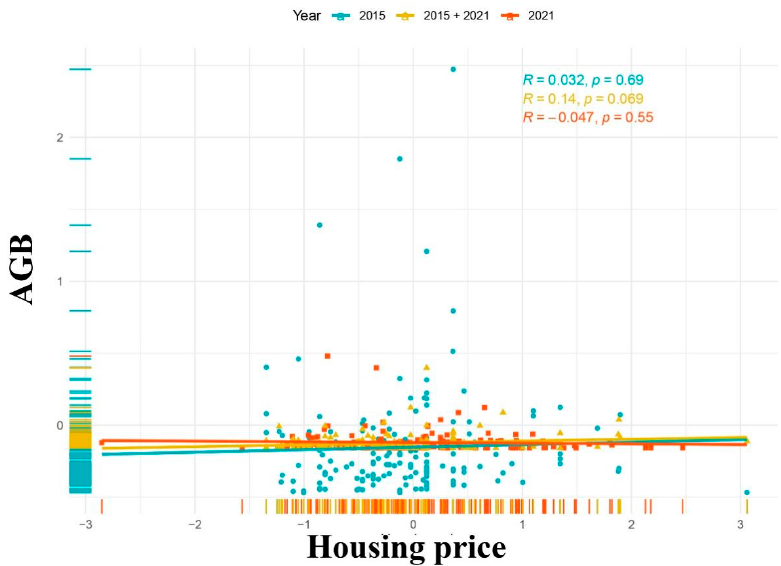
Figure 3. Scatterplot depicting the relationships between AGB and housing price in Haikou in 2015, 2021, and 2015 with 2021. 2015 + 2021 represents univariate analysis of the number of species in 2021 and socioeconomic factors in 2015.